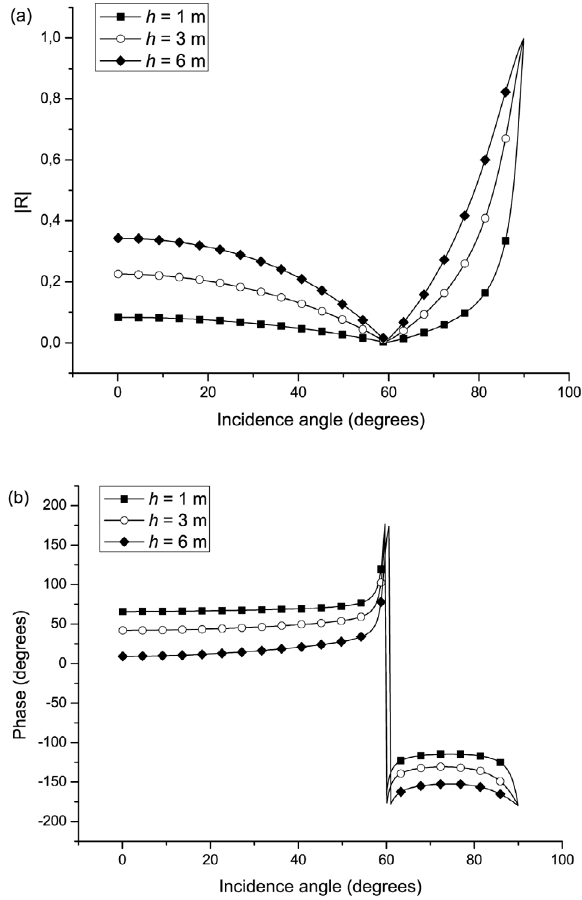
Figure 5. Sandstone layer in mudshale. Absolute value (a) and phase (b) of the SH-wave reflection coefficient as a function of the inci- dence angle and three values of h